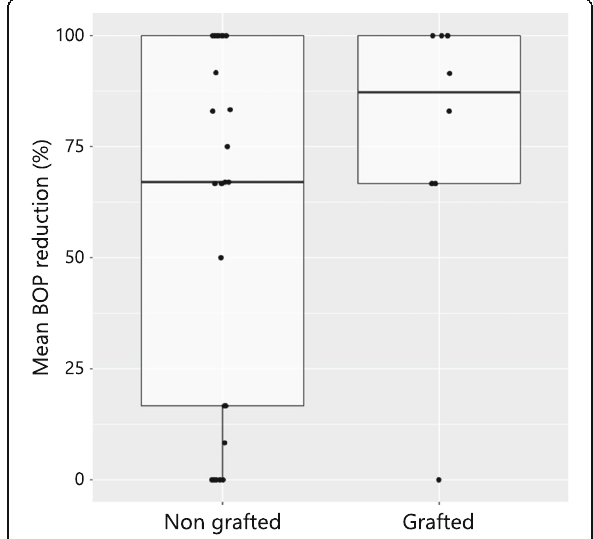
Fig. 4 Box plot presenting mean BOP reduction between the two patient groups (grafted and non-grafted) with no significant difference ( p = 0.778)